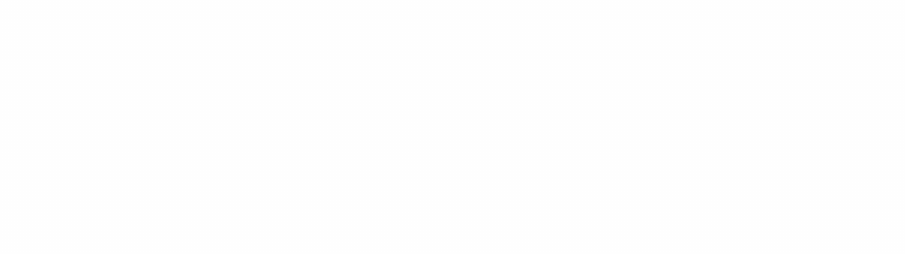
Fig. 3: Representation of videofragments of GMs of two infants aged 3 months post term. The fragments start at the upper left hand comer and should be read as the lines in a book. The interval between the frames is 8.16 s. The infant in the upper panel (A) was born at term. She shows normal, variable, and complex GMs. The variation is illustrated by the different postures of the limbs in the different frames. Movement complexity is exemplified by the movement of the left leg on the third row: the movement is not a simple flexion-extension movement, but a flexion-extension combined with a simultaneous abduction at the hip and an endorotation of the foot. The infant in the lower panel (B) is born prematurely at a gestational age of 28 weeks. She has definitely abnormal GMs. The deviant character of the movements is expressed by the lack of variation: the frames have a high degree of similarity. The frames give the false impression that the infant did not move at all, but she moved equally much as infant A. (Figure published with permission of the parents and the Nederlands Tijdschrift voor Geneeskunde where the figure was published originally [Hadders-Algra 1997, 141, p.